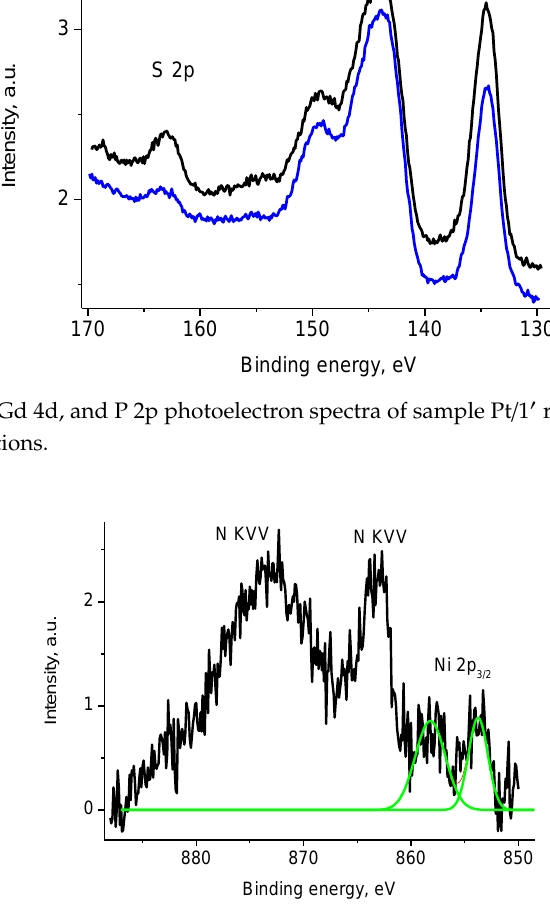
Figure 24. The Ni 2p photoelectron spectrum of sample Pt/1’ (initial spectra – black, basic curves – green, resulting curve – red).